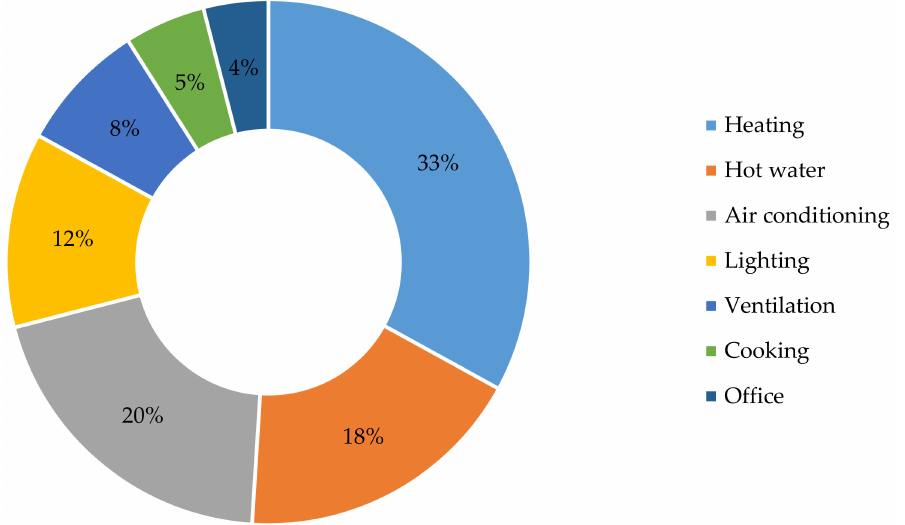
Figure 1. Structure of primary energy consumption in the analyzed hotel facility.